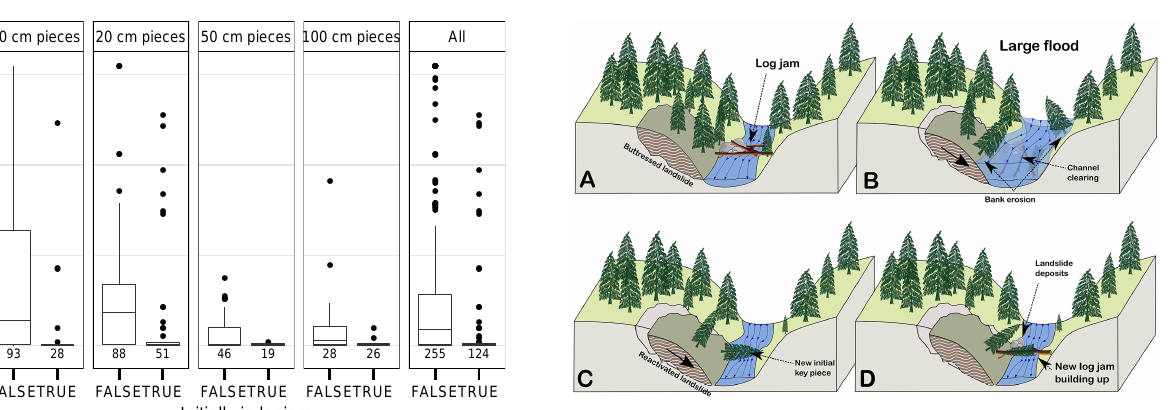
Figure 8. Visualization of the four-stage conceptual model for log jam dynamics and wood transport in steep headwater streams. (a) Mountain stream channel after longer period without large flood.